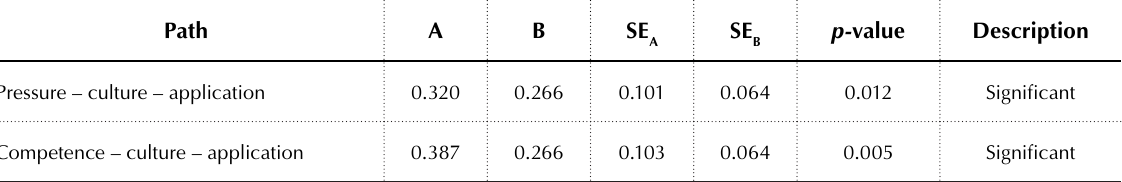
Table 3. Sobel test